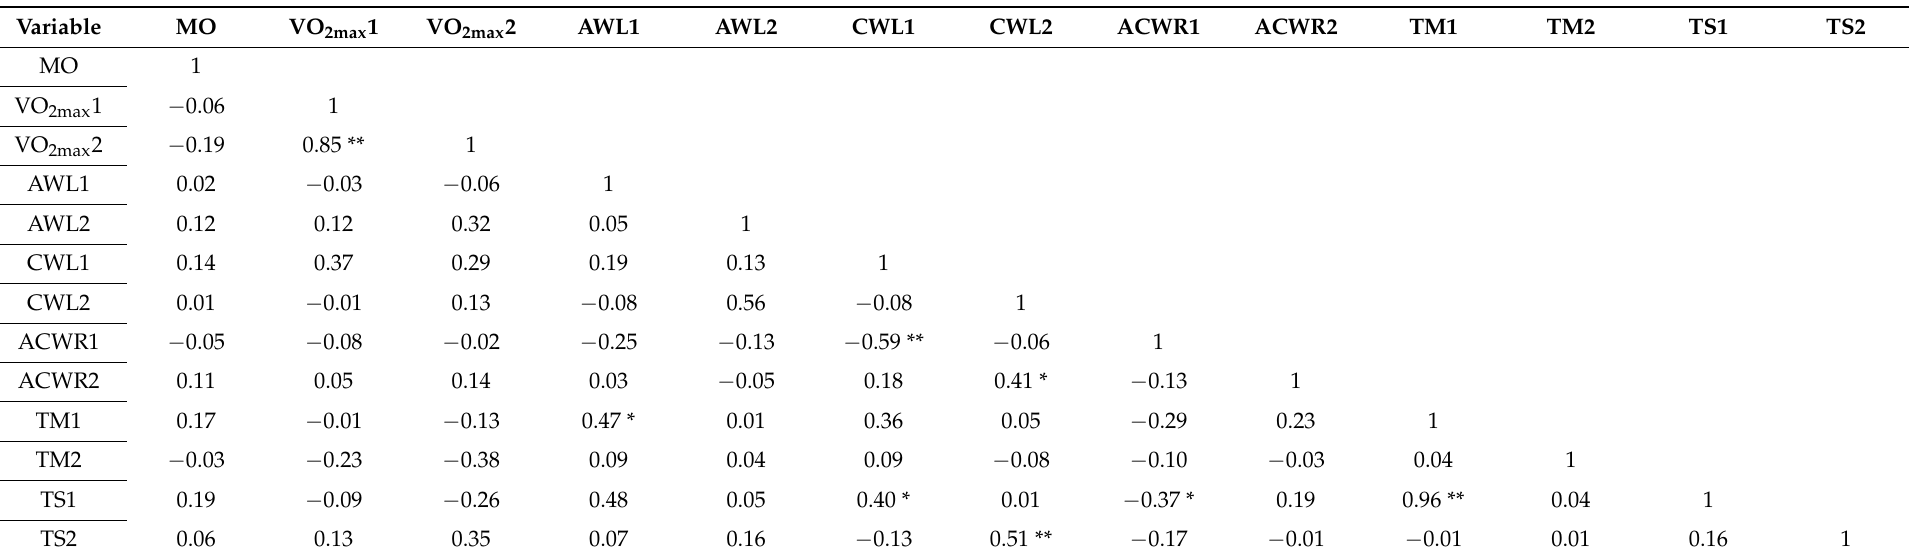
Table 2. Correlations between the maturity offset workload parameters and locomotor